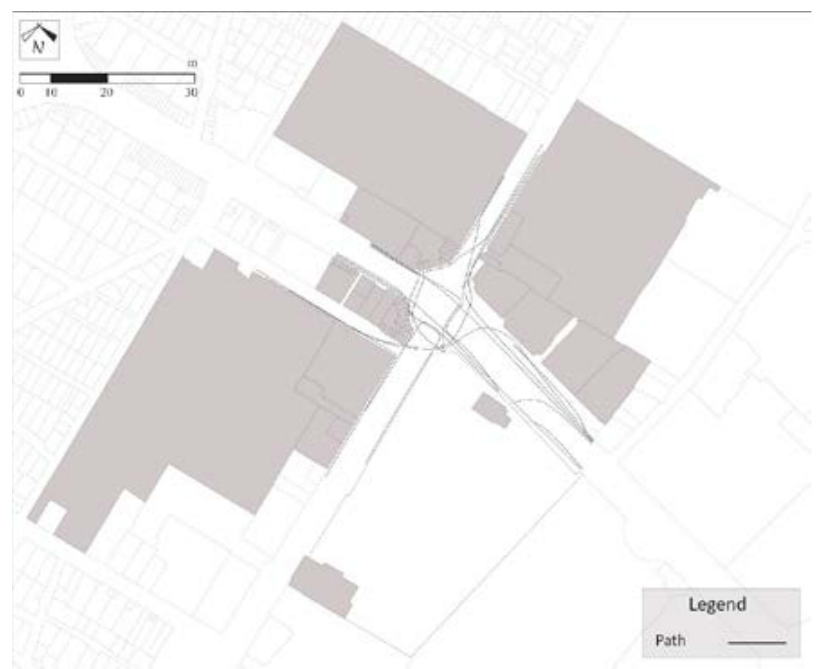
Fig. 11: Tracking the path (night); source: authors